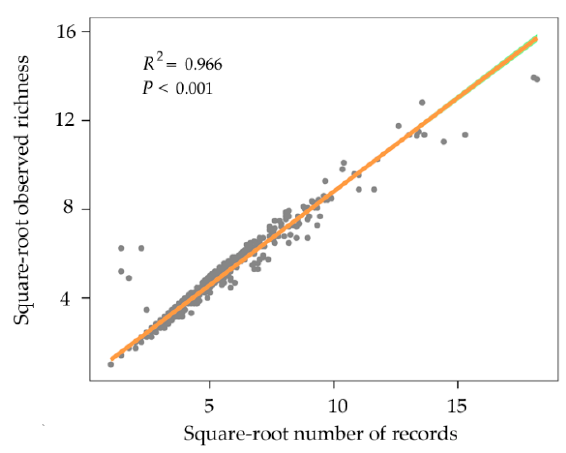
Figure 3. Linear regression (y = 0.844x + 0.367) for the square-root number of records and square-root number of richness in a 1° grid.